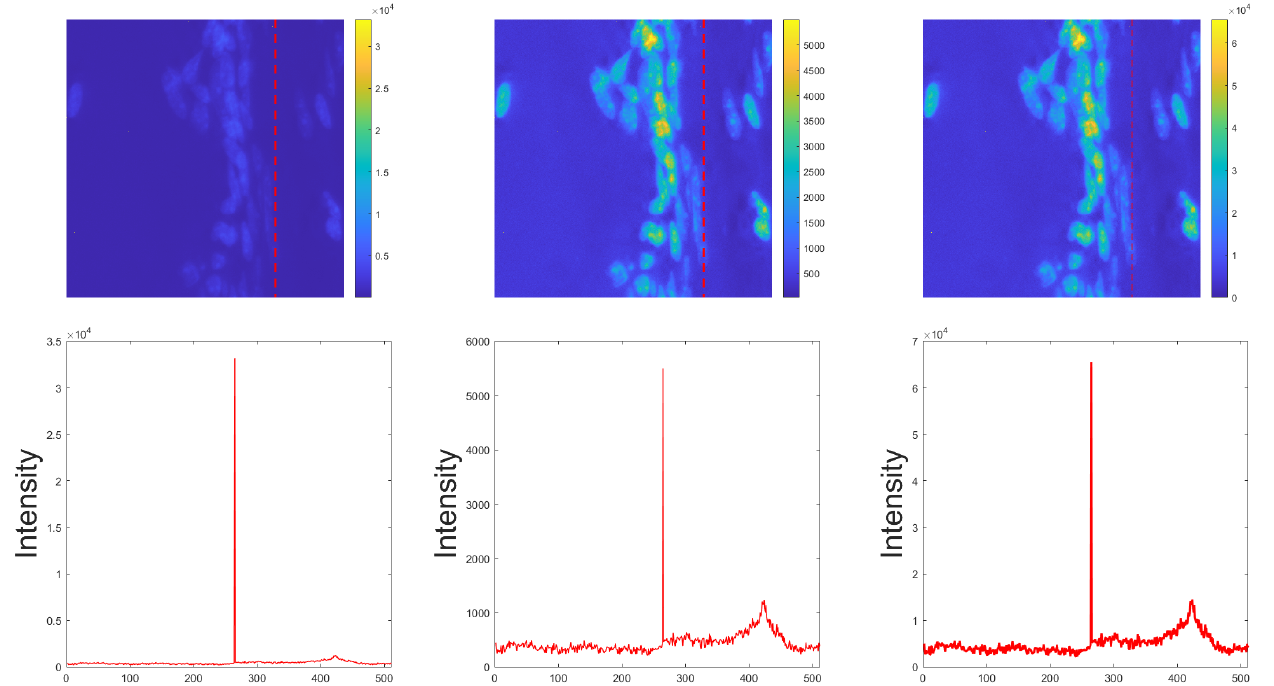
Figure 2. Example of raw, outlier-removed and normalised 16 bit images of a bone sample at 40 × magnification from left to right in the first row, respectively. We also plot a profile intensity line (depicted with dashed red lines in the images) in the second row. The raw 16 bit image was selected from the BitDepth